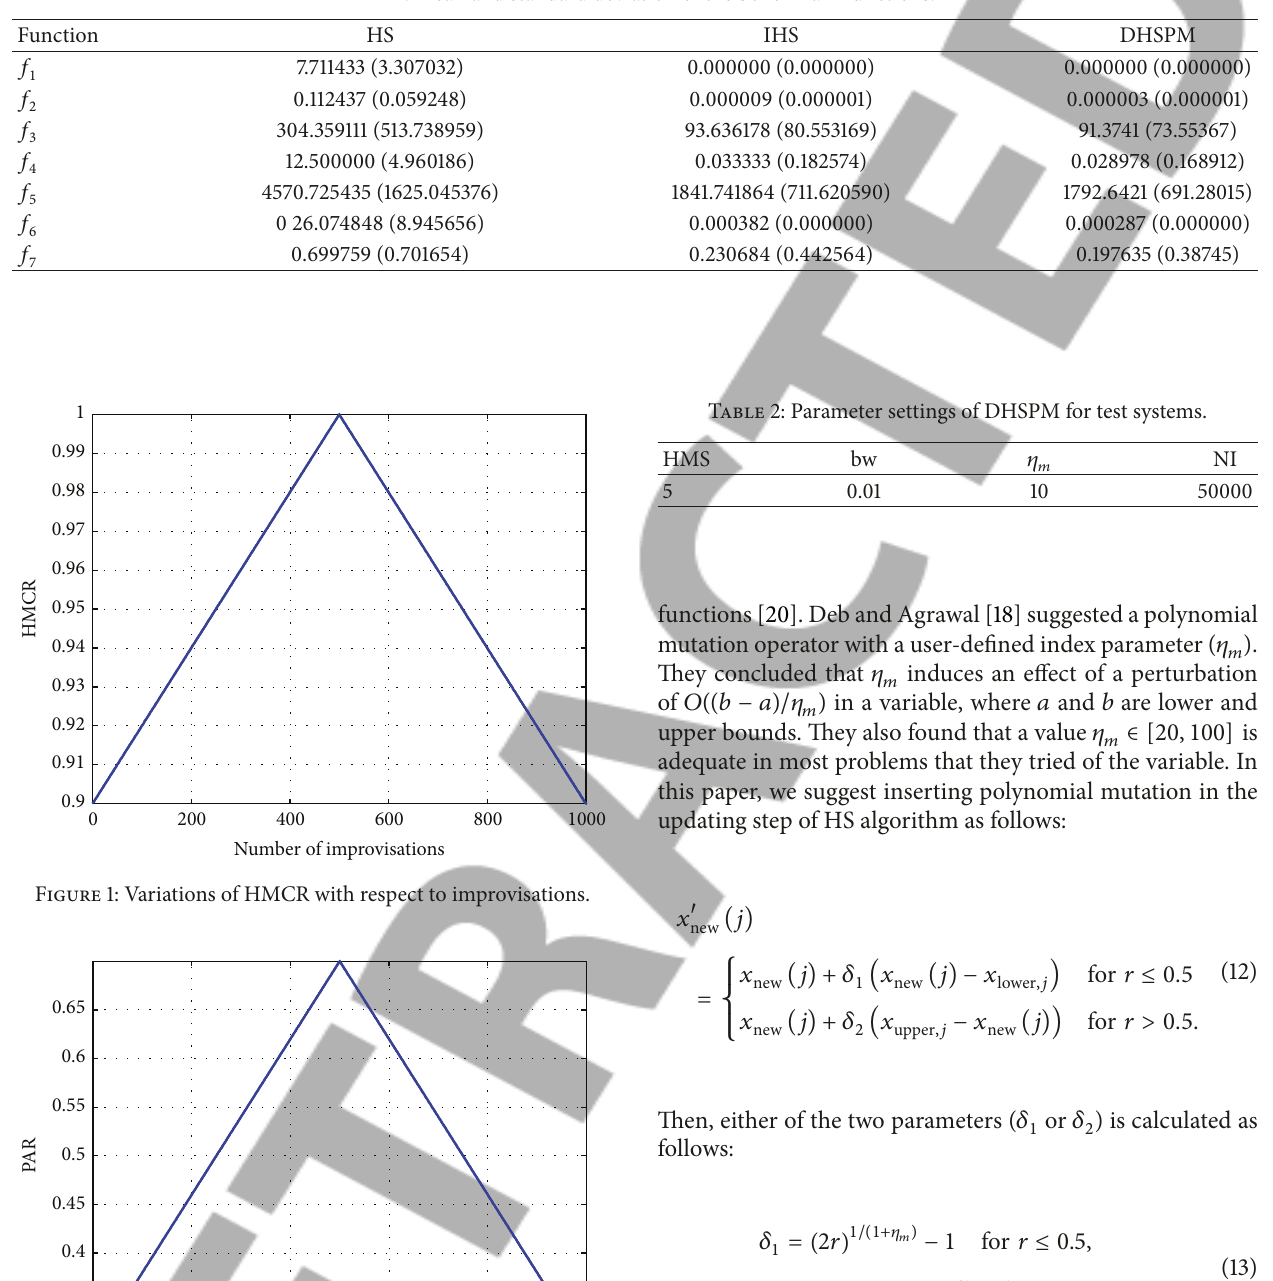
Table 1: Mean and standard deviation of the benchmark functions.